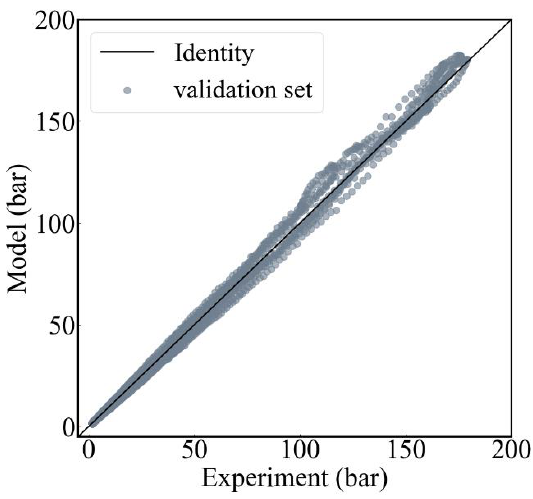
Figure 9. Regression analysis of validation set.